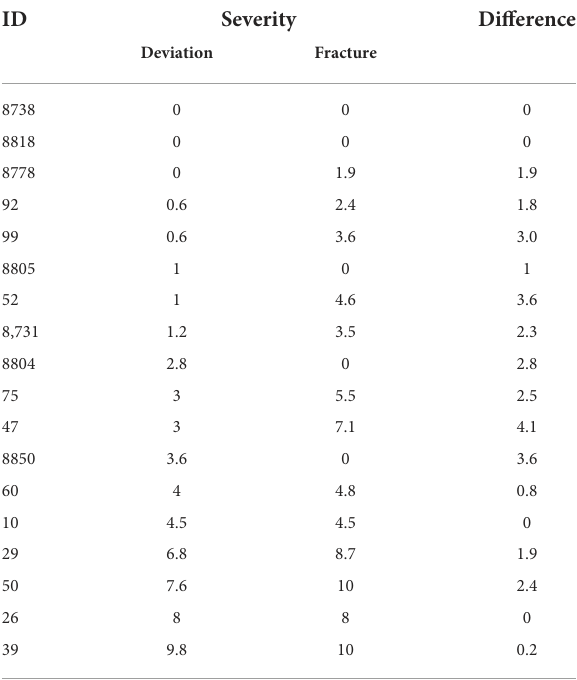
TABLE 3 Eighteen randomly selected examples for laying hen keel bone x-rays that show in any case a fracture when the threshold of 3.8 for deviation is exceeded (last six